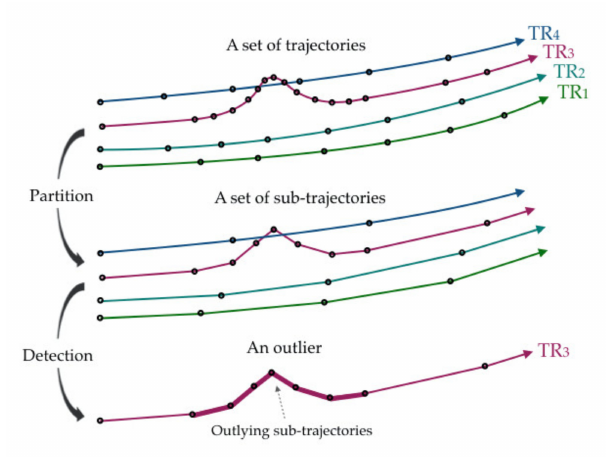
Figure 6. Partition-and-detect framework